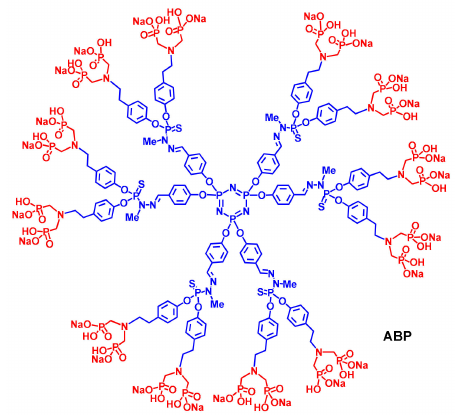
Figure 2. Structure of the ABP dendrimer. The cyclotriphosphazene core (N 3 P 3 ) and the PMMH branches (including the point of divergence) are in blue. The twelve tyramine-based (in blue) ABP surface groups are in